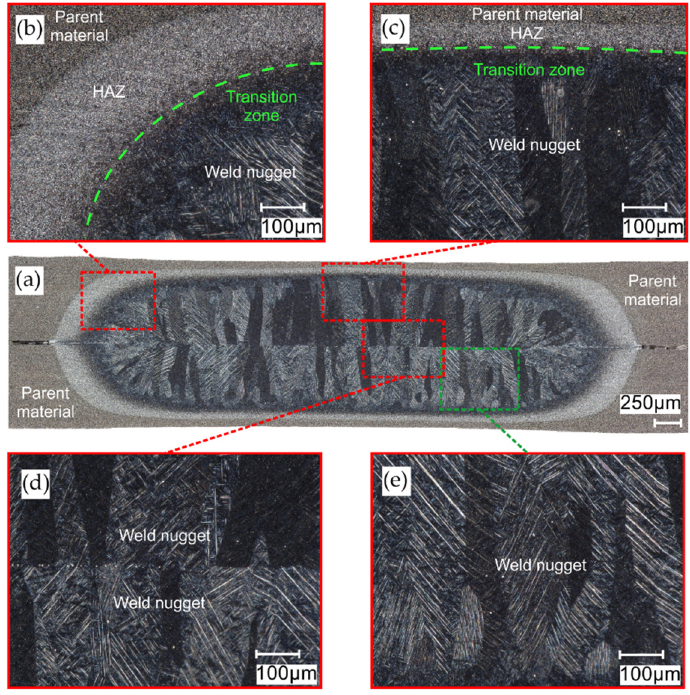
Figure 11. Microstructure of weld in the Gr5–Gr5 joint: ( a ) panorama of the weld; ( b , c ) transition zone between the weld nugget, HAZ and parent material; ( d ) weld nugget center and ( e ) weld nugget zone.